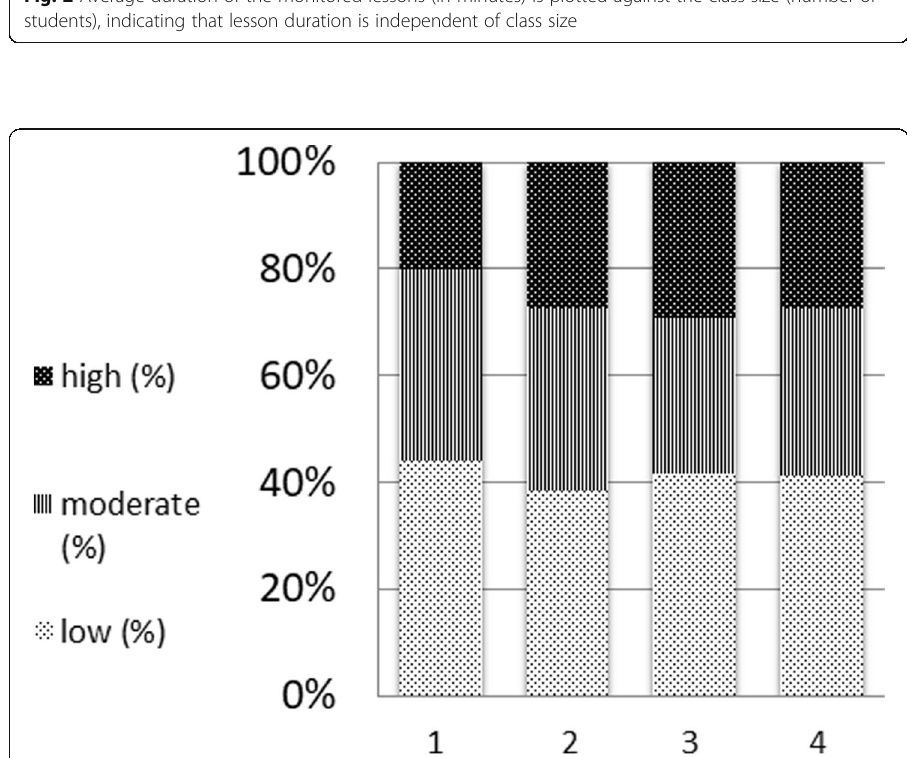
Fig. 3 The average pattern of high, moderate and low performers per phase of all students, for all implementations in the framework Inspiring Science Education pilots. Phases: 1 = Orienting & Asking Questions; 2 = Hypothesis Generation & Design; 3 = Planning & Investigation; 4 = Analysis & Interpretation. The last lesson phase (conclusion and interpretation) is not included as those tasks did not involve problem-solving